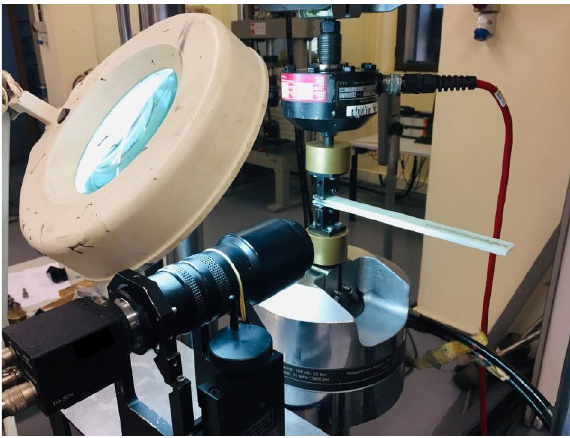
Figure 1. Arrangement of specimen on the test rig.